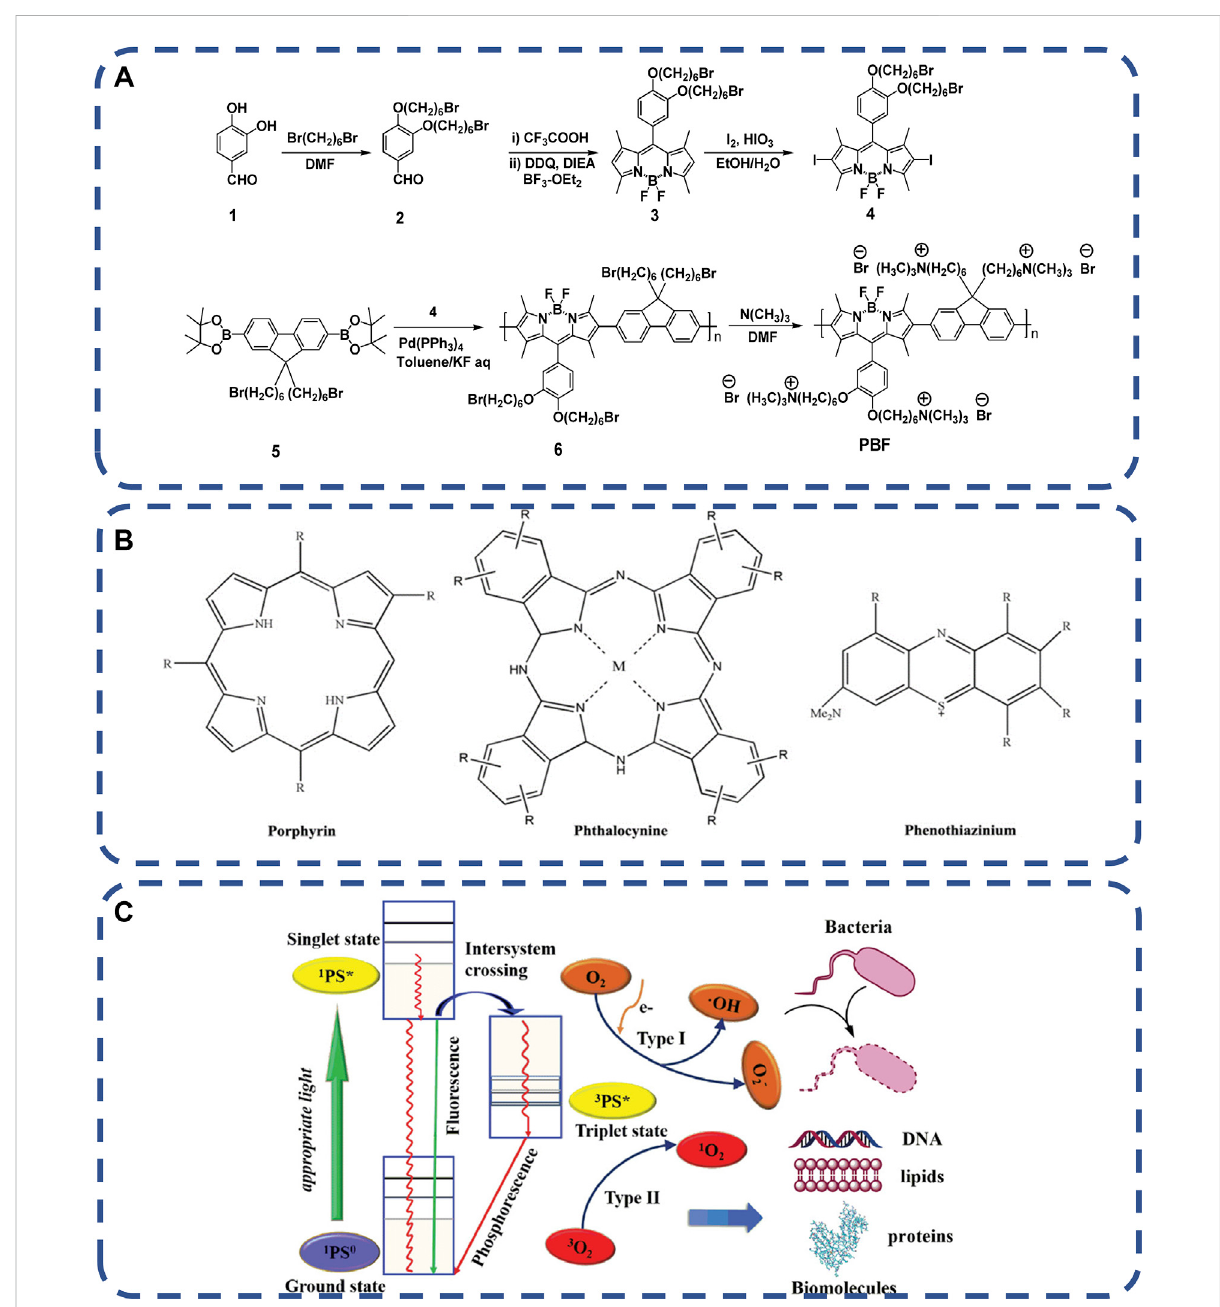
FIGURE 5 (A) Synthesisrouteofwater-solublepolymerPBF(Gontsariketal.,2019).Copyright2012,Langmuir. (B)